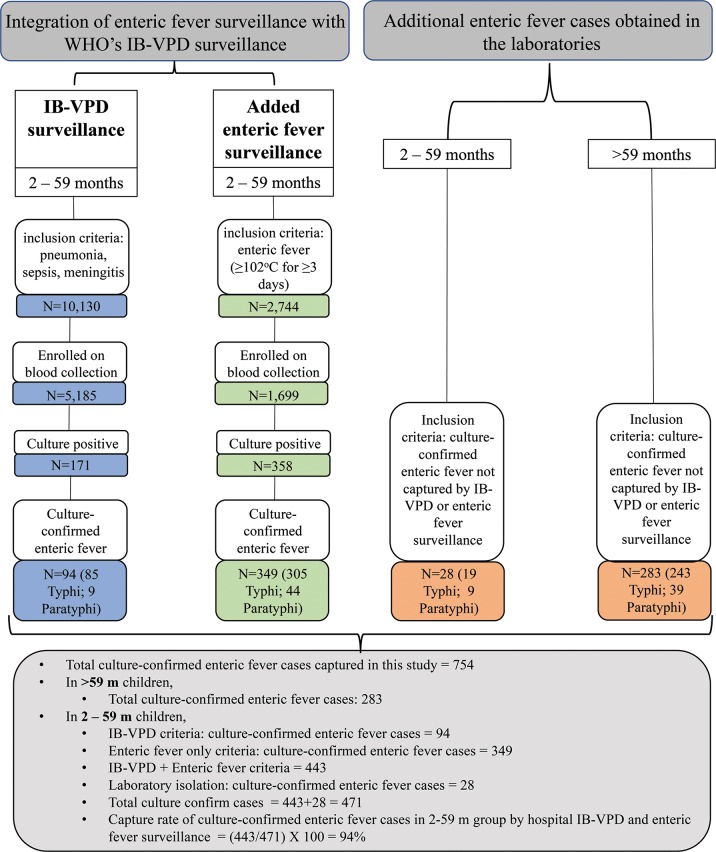
Overview of integration of enteric fever surveillance into the WHO-coordinated IB-VPD surveillance system.